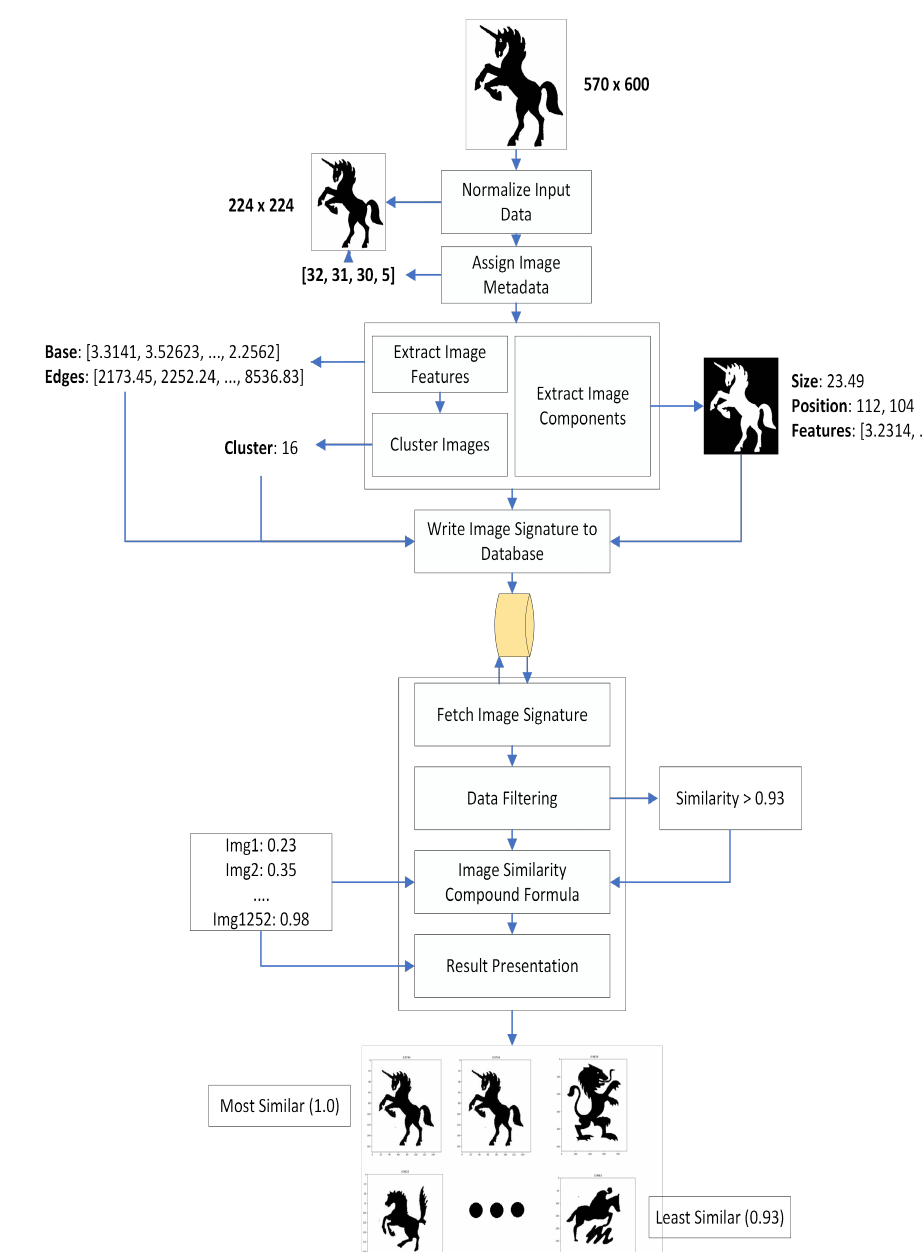
Figure 8. Image signature building and comparison process